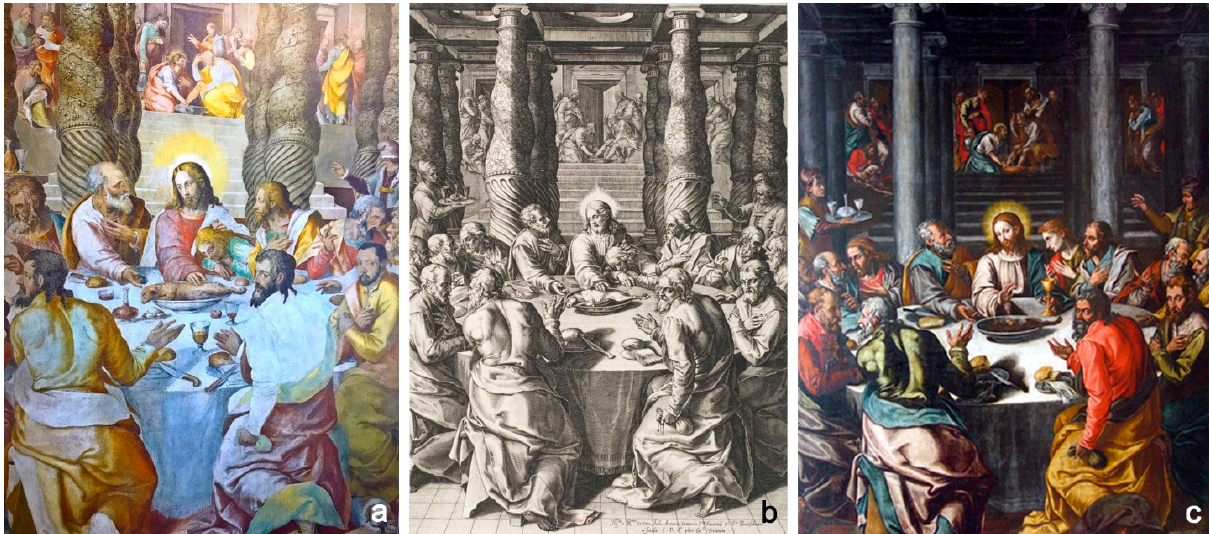
Figure 2. ( a ) Fresco by Livio Agresti, “Last Supper”, 1569; ( b ) Cornelius Cort engraving, “Last Supper”, 1578; ( c ) unknown painter, “Last Supper”, Church of San Rocco di Montorio.